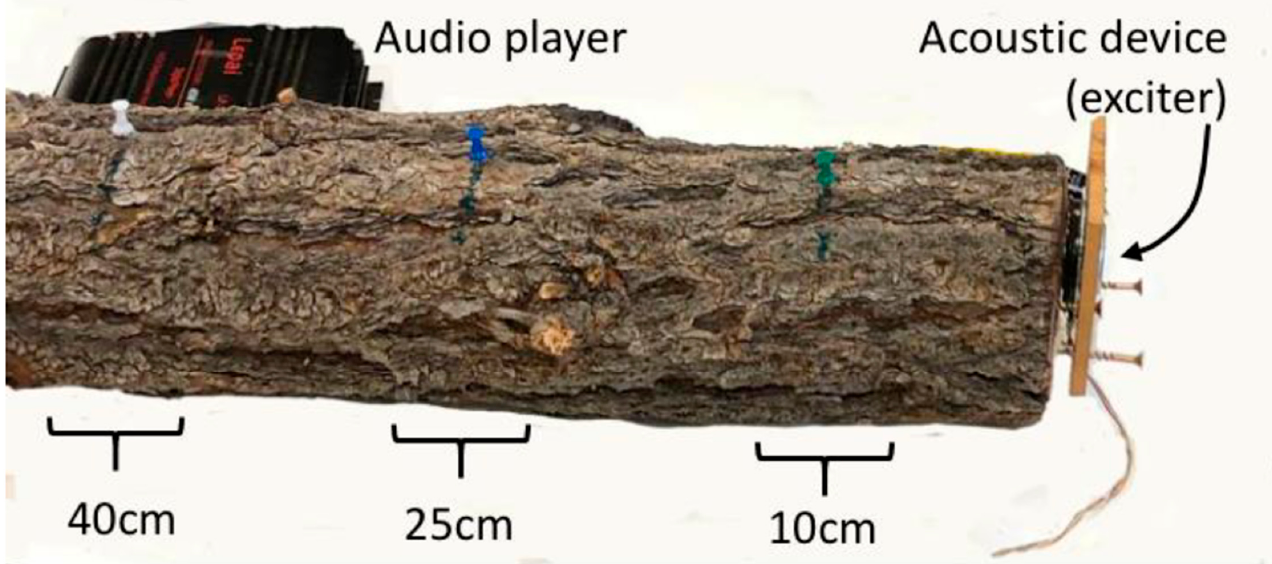
Figure 4. Acoustic treatment assay setup. Pinyon log with the labeled distances: 10 cm (green pin), 25 cm (blue pin), 40 cm (white pin) where beetles were introduced. Placement of acoustic device at end of cut log. Audio player (dark object) also in image.